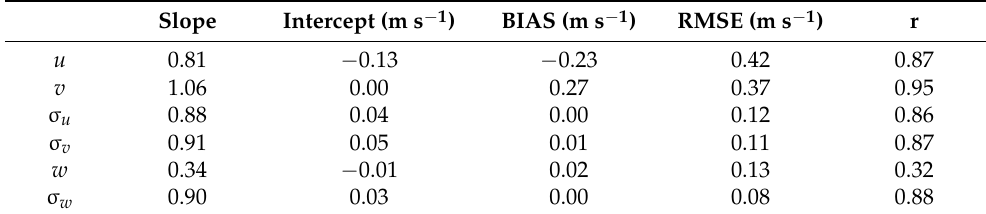
Table 4. Regression results for the comparison of the mean and standard deviation of the 3-D sonic wind velocity components, plus estimates for bias, comparability (RMSE), and Pearson’s coefficient (r). Slope Intercept (m s − 1 ) BIAS (m s − 1